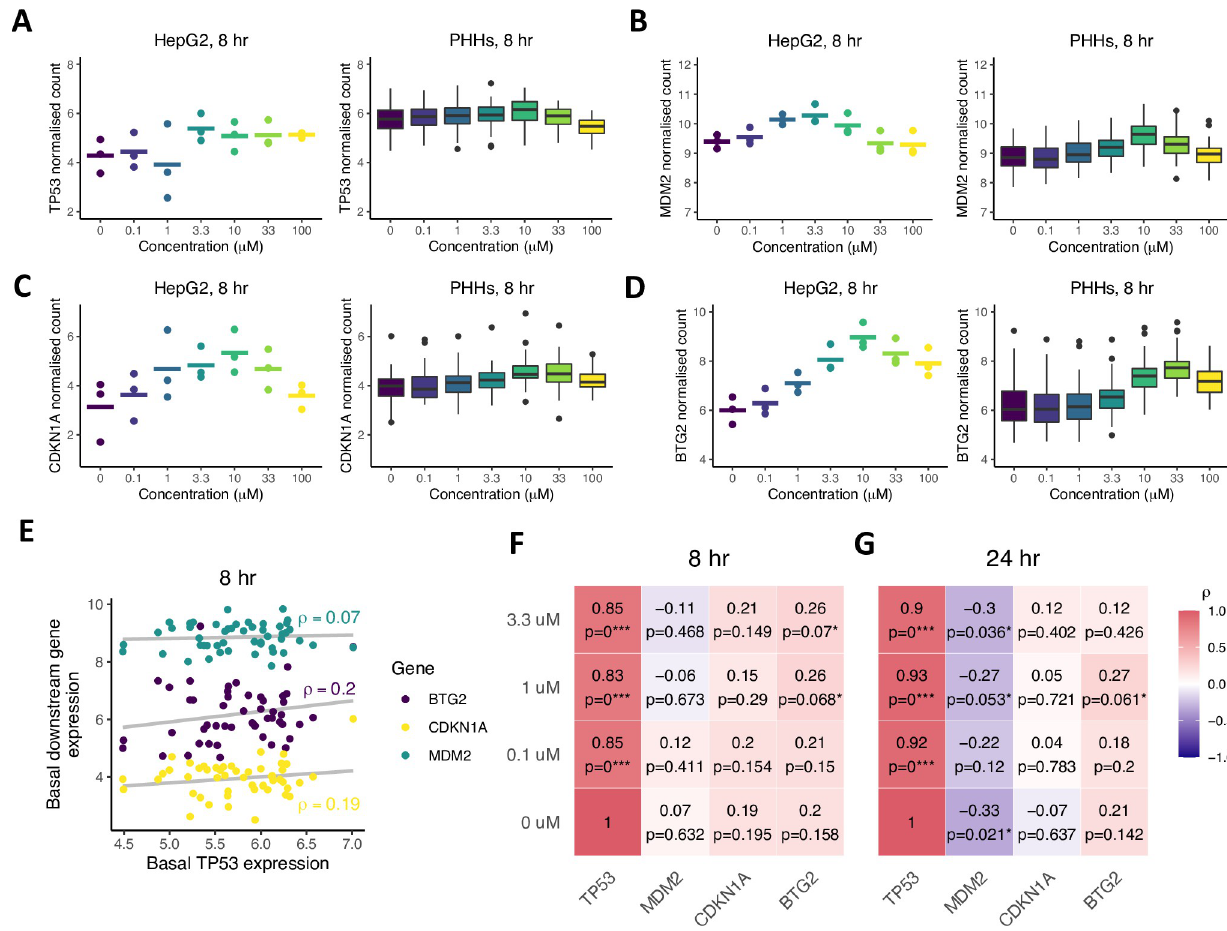
Fig 2. Expression patterns and correlations between TP53 and its downstream targets in HepG2 cells and 50 PHHs at increasing cisplatin levels. (A-D) TP53 (A), MDM2 (B), CDKN1A (C) and BTG2 (D) gene expression patterns as a function of cisplatin concentration in HepG2 cells (3 replicates (dots) and their mean (line segments), left panels) and PHHs (right panels) at the 8-hour time point. Note that at high cisplatin concentrations, gene expression declines, which is likely explained by cytotoxicity onset. (E) Basal downstream target correlations with basal TP53 expression at the 8-hour timepoint. (F-G) Correlation strengths between TP53 and the downstream targets MDM2 , CDKN1A and BTG2 after exposure to 0, 0.1, 1 and 3.3 μ M cisplatin at 8 (F) and 24 (G) hours. � p-value < 0.1, �� p-value < 0.01, ��� p-value <